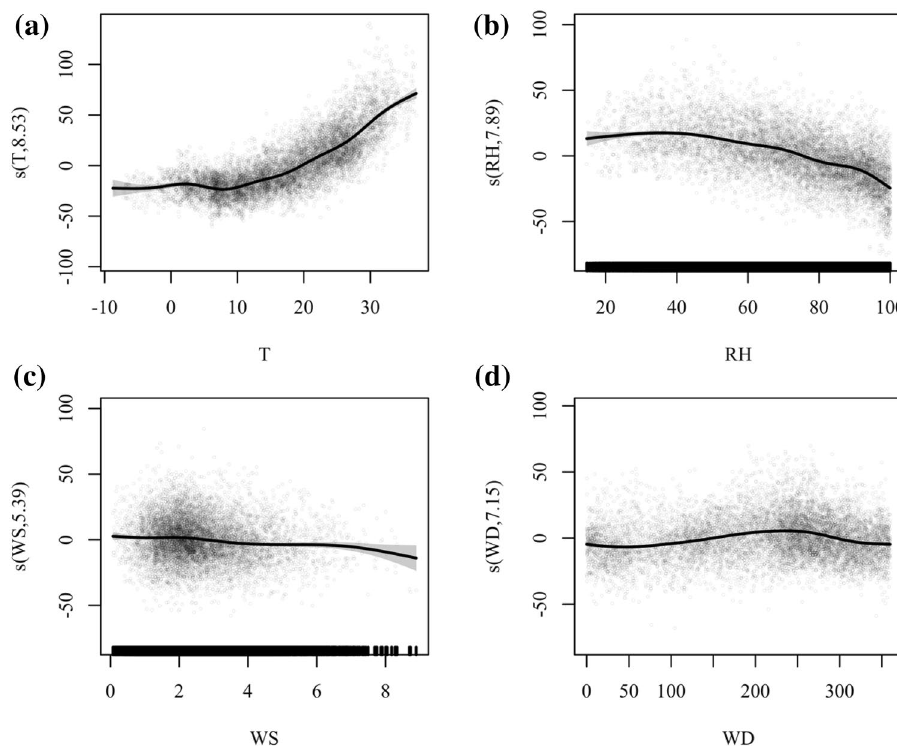
Fig. 6 Plot of partial depend- ence of meteorological variables on O in representa- 3 tive cities. Panel a show the relationship between O and 3 T in Hefei; Panel b show the relationship between O and 3 RH in Huangshan; Panel c show the relationship between O 3 and WS in Huangshan; Panel d shows the relationship between O and WD in 3